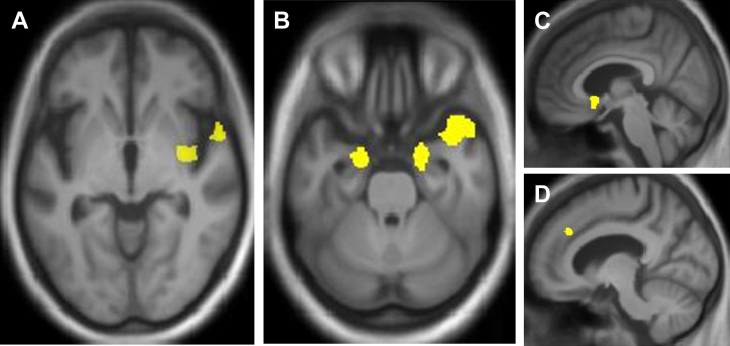
Statistical parametric maps (SPMs) showing regional grey matter atrophy significantly associated with: A, any auditory hedonic symptoms in the combined FTLD cohort, centred on right anterior temporal lobe, insula and putamen; B, C, environmental sound aversion in the combined FTLD cohort, including anterior temporal cortex, amygdala and nucleus accumbens; D, environmental sound aversion in the AD cohort, in anterior cingulate cortex. The neuroanatomical associations of music aversion in the FTLD cohort (not shown) comprised a similar distributed fronto-temporal network (see Table 2). SPMs are thresholded at p < .05 after small volume correction for multiple voxel-wise comparisons in pre-specified small anatomical volumes of interest and displayed on sections of a group mean T1-weighted MR brain template image in MNI standard space; the right hemisphere is shown on the right of the axial sections. AD, Alzheimer's disease; FTLD, frontotemporal lobar degeneration.